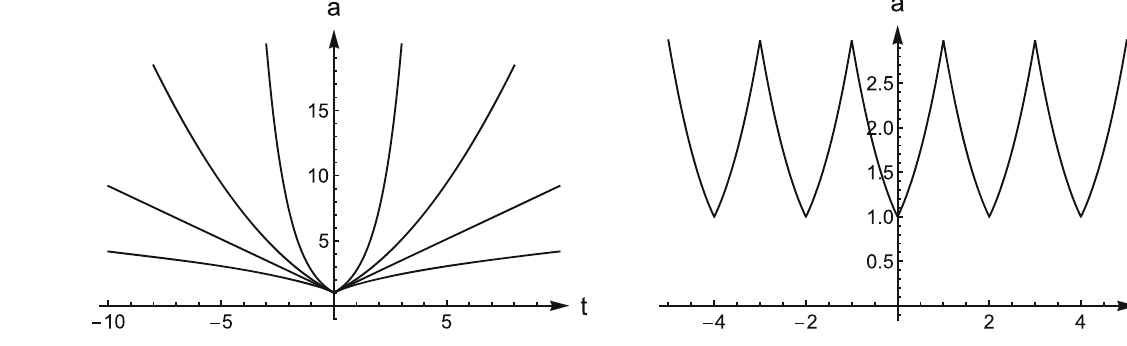
ical time crystal where ˙ a reverses signs at both a ± = 1 , 3. The theory involves massive gravity, discussed in the third example